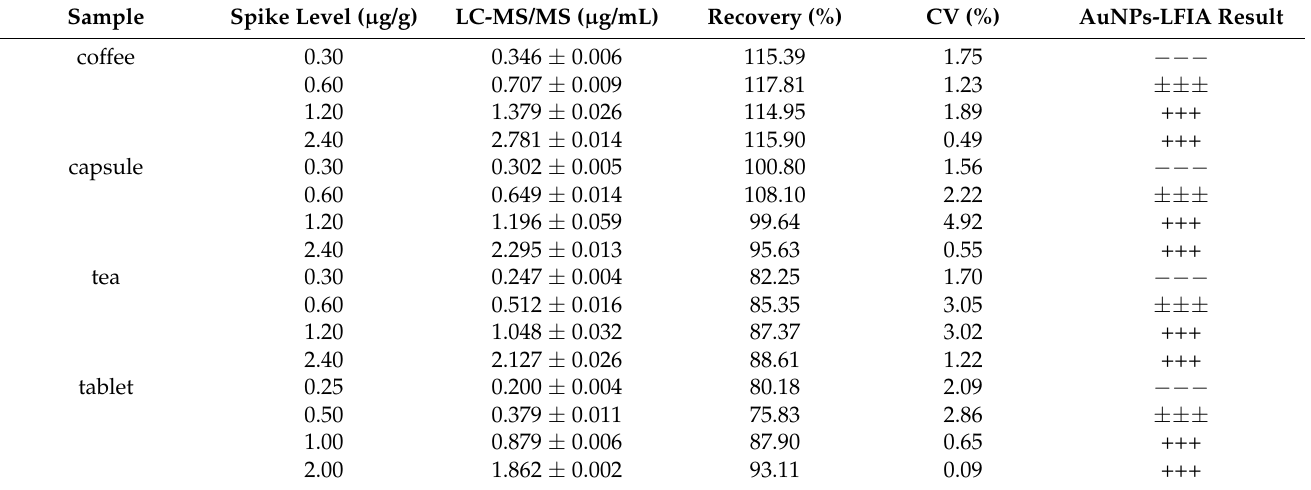
Table 1. Comparison of the detection results of the Au nanoparticles lateral flow immunochromatography (AuNPs-LFIA) and the liquid chromatography with tandem mass spectrometry (LC-MS/MS) in slimming health foods spiked with furosemide ( n =